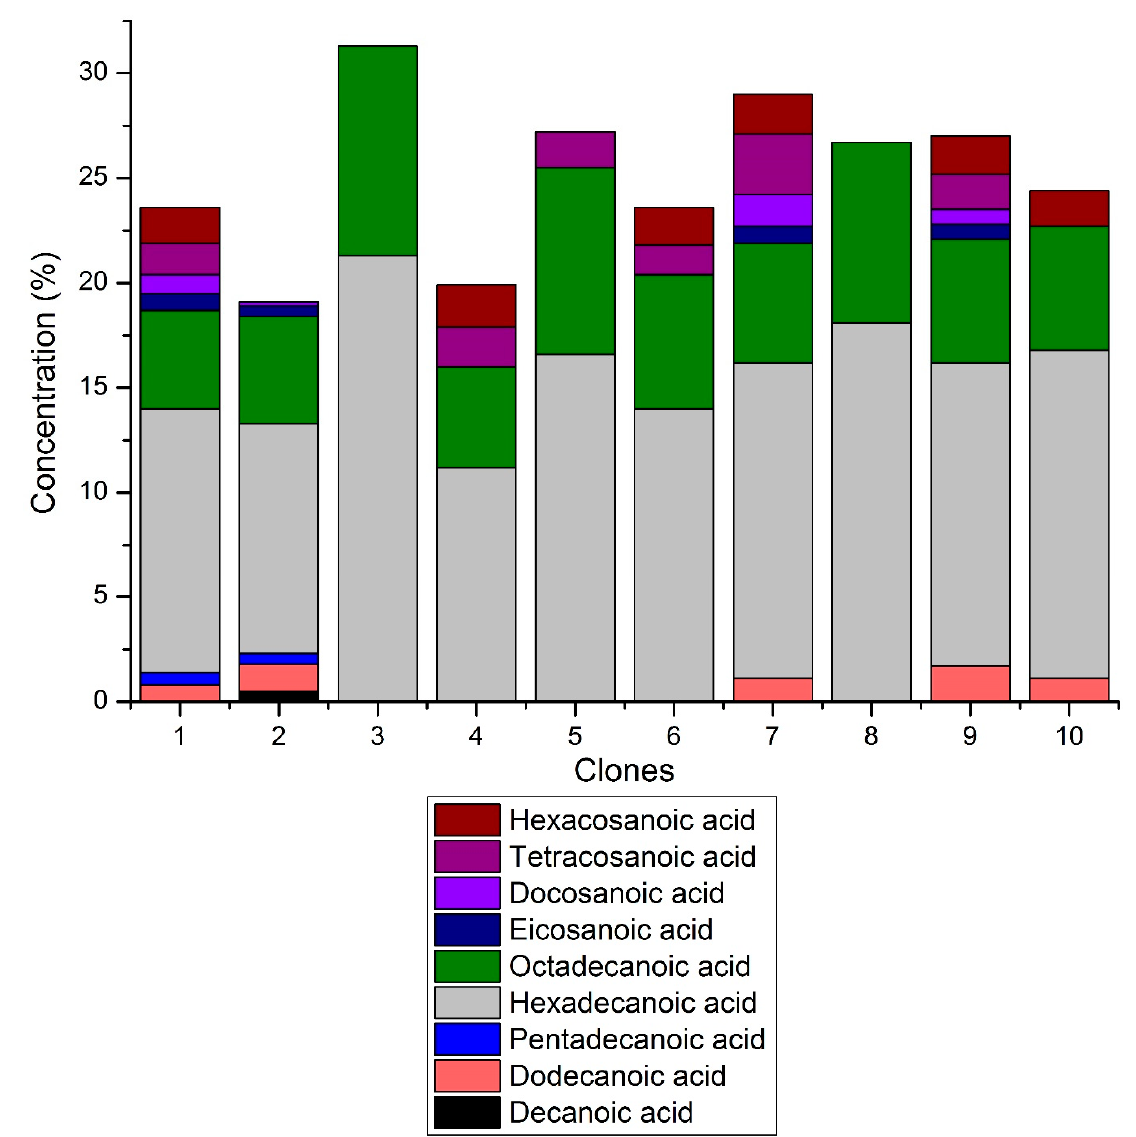
Figure 5. Fatty acid contents of Eucalyptus spp. identified in lipophilic dichloromethane extracts. The values determined for fatty alcohols, steroids, glycerol derivatives and triterpenes are shown in Figure 6. Variations from 0.0% (Clones 3, 4, 6, 7, 8, 9, 10) to 3.5% (Clone 1) were found for fatty alcohols, and from 0.0% (Clones 3, 4, 5, 7 and 9) to 10.5% (Clone 8) for glycerol derivatives. The occurrence of triterpenes was identified only in Clone 9 (1.8%). Substituted alkanoic acids were identified in the lipophilic extracts, with an aver- age content of 9.9% among the evaluated clones. Trans-9-octadecanoic acid and 9,12- octadecanoic acid were also identified (Figure